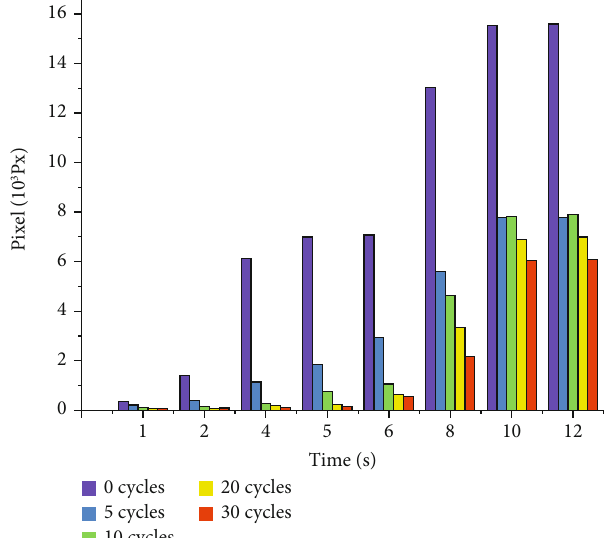
Figure 12: Area-time curve of the new damage zone.